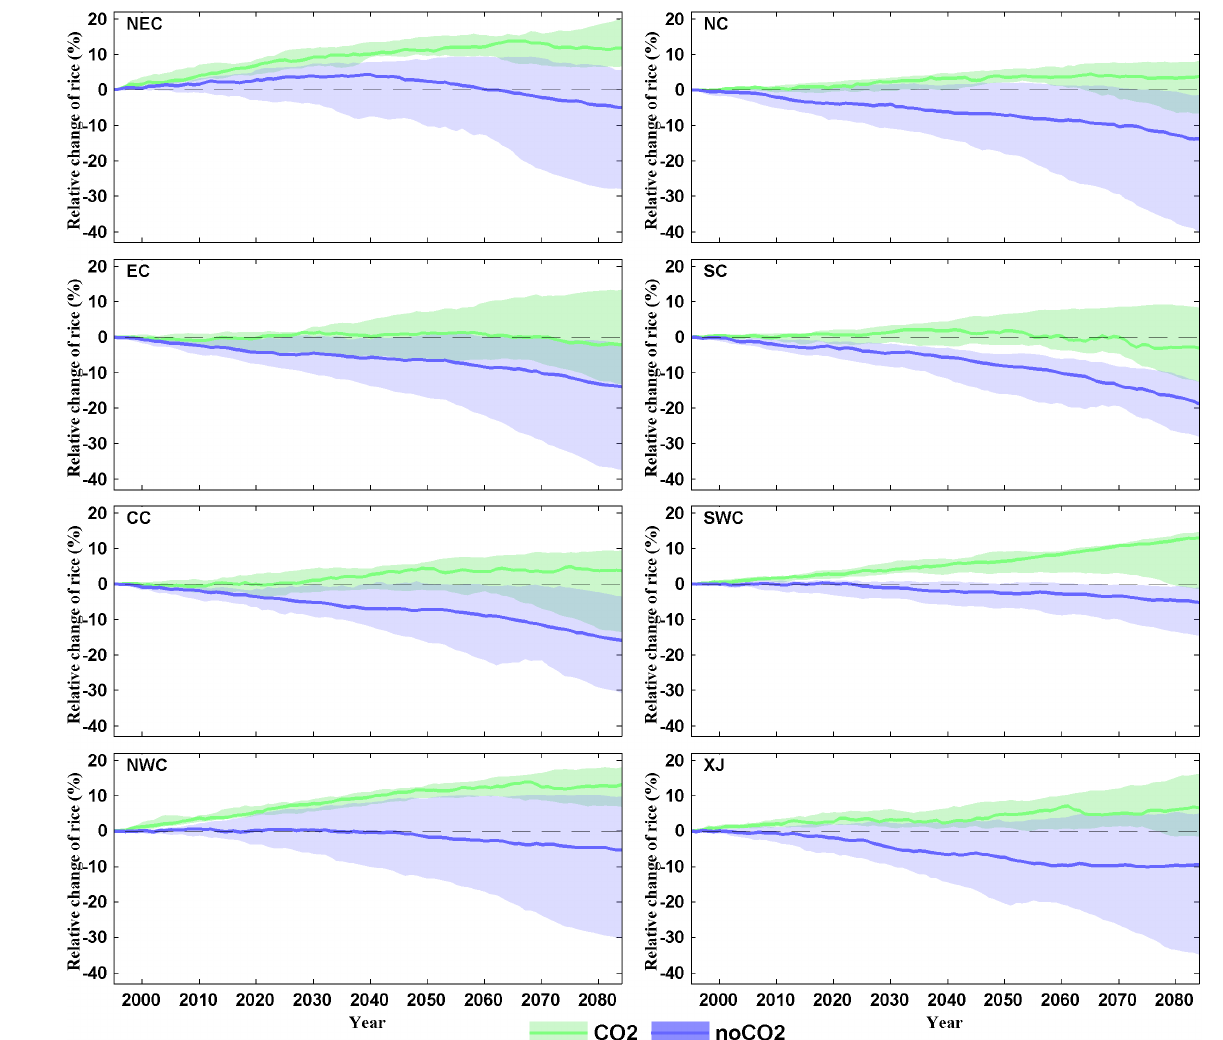
Figure 5. The relative change in the simulated rice yield in the eight regions with (without) the CO 2 effect. The MMs and the 25th and 75th percentiles of the model pairs are